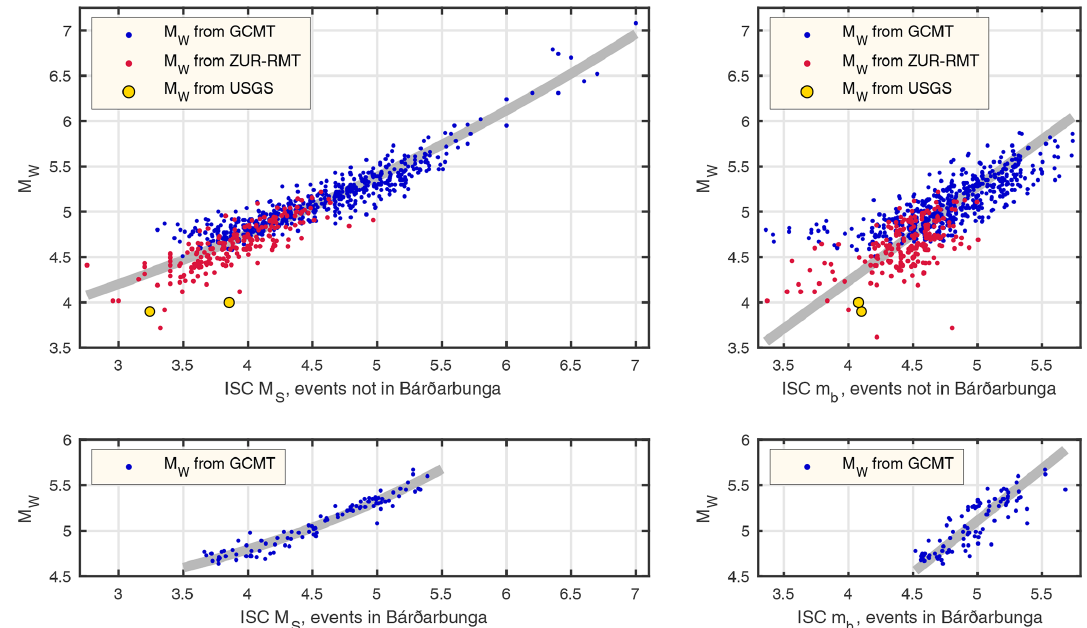
Figure 3. Magnitude pairs for earthquakes in the northern Mid-Atlantic Ridge (NMAR) region 1976–2019, exponential relations for M s and linear relations for m b , all fitted with χ 2 regression. There are 733 M w – M s pairs outside Bárðarbunga and 95 in it and 744 M w – m b pairs outside and 97 in Bárðarbunga. Note that a few earthquakes with m b < 3 . 5, thus not included in the final catalogue, are used for the regression. A slight random jitter has been applied to the pairs to avoid superimposing different data points. Table 1. Parameters of exponential and linear models for M w , obtained with σ(M w ) = 0 . 09; see Eqs. (5) and (6), RMSD is the root-mean- square deviation between the model and the y coordinates of the data, and the last column gives the estimated σ(m b ) and σ(M s ) . Model a b c RMSD Uncertainty Non-caldera M w ∼ M s 0.850 0.143 0.613 0.142 0.174 Non-caldera M w ∼ m b 0.070 1.041 0.257 0.225 Caldera M w ∼ M s − 1 . 401 0.383 3.657 0.072 0.009 Caldera M w ∼ m b − 0 . 585 1.139 0.153